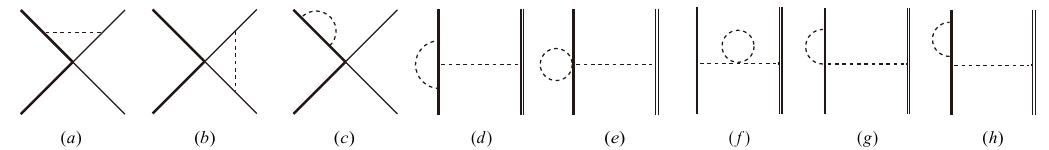
Figure 4 . The next-to-leading order Feynman diagrams that contribute to the vertex corrections and wave function renormalizations. Each graph denotes the one type of diagrams with the same topological